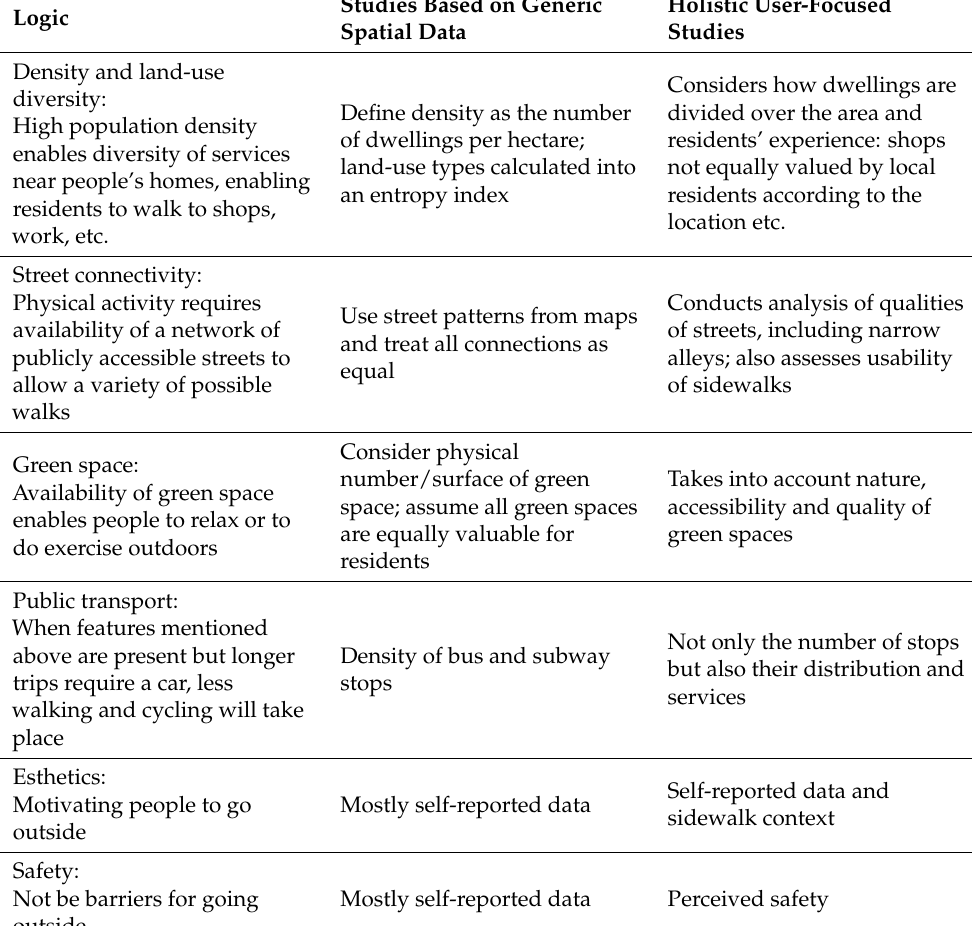
Table 1. Built environment parameters, expected impacts on PA, and operational